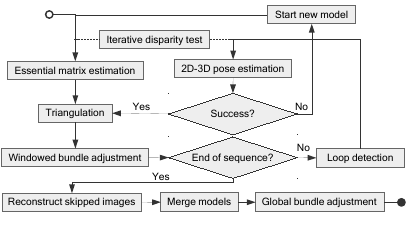
Figure 1: SfM pipeline